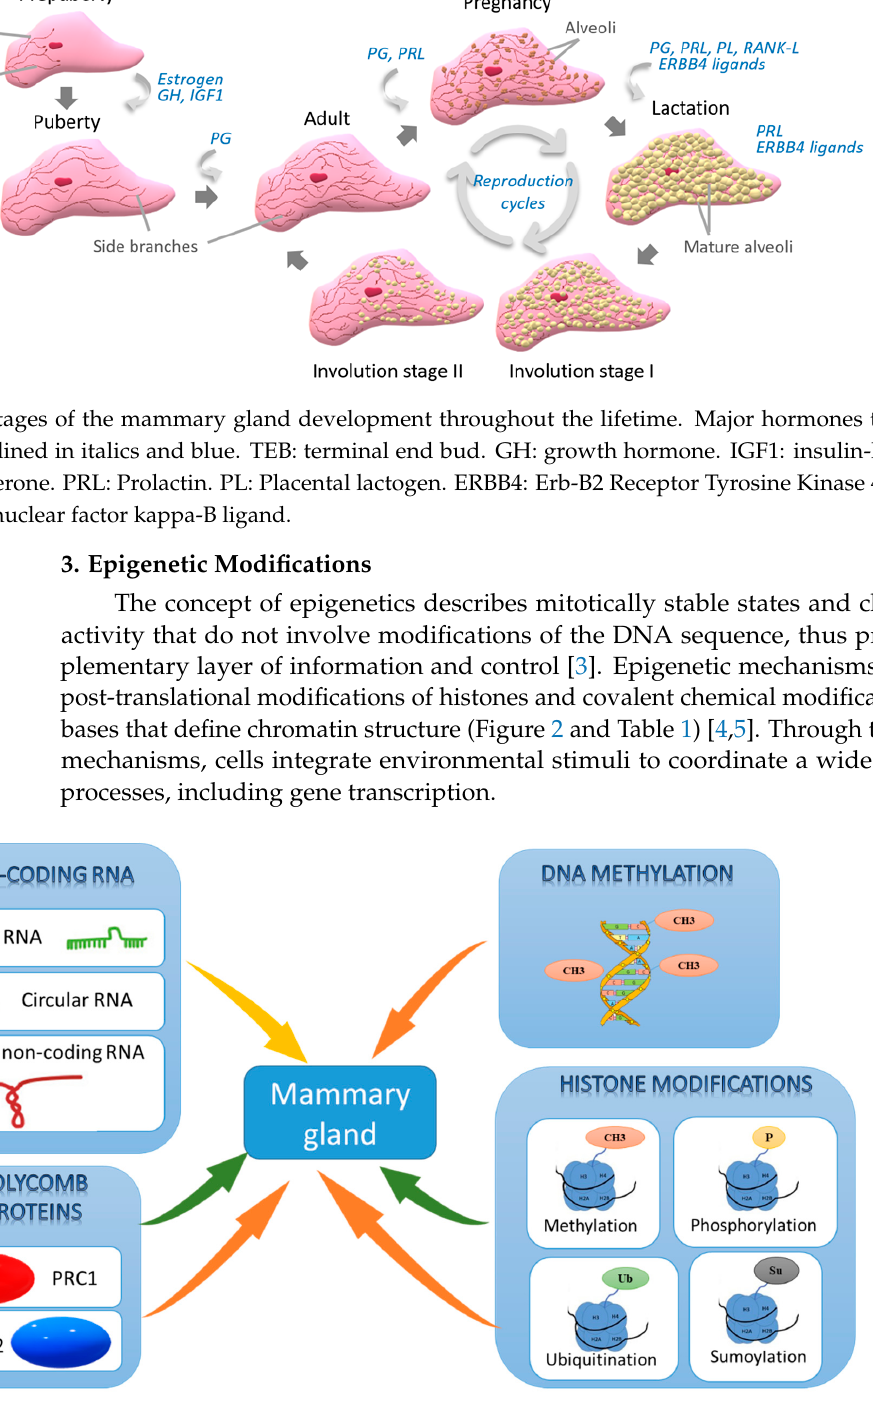
Figure 2. Main epigenetic modifications impacting mammary gland development. Post translational regulation (yellow arrow), alteration of chromatin structure (green arrow), and gene activation or inactivation (orange arrow). Table 1. Summary of epigenetic modifications and enzymes that play a role in mammary gland development and function. Groups of Epigenetic